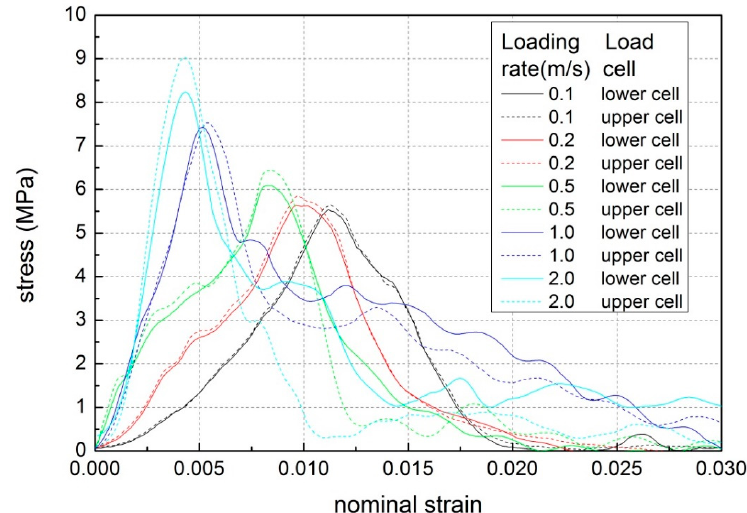
Figure 8. Typical stress versus nominal strain-rate profiles of hard ice at different loading rates at − 10 °C. (Results derived from upper load cell are shown in dot lines and results derived from lower load cells are shown in solid lines). Table 1. Uniaxial compressive strength results of hard ice with two temperatures, two loading directions and five loading rates.